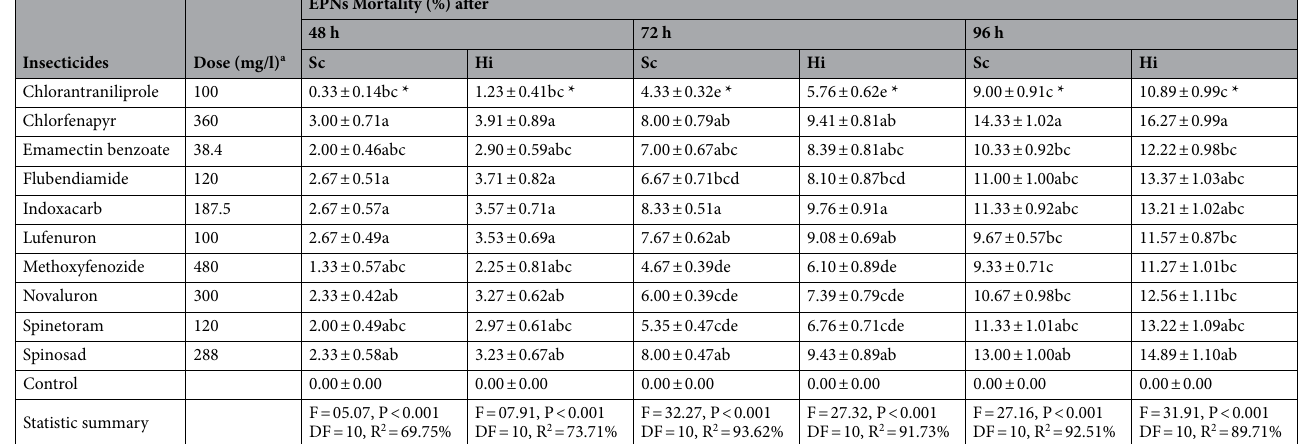
Table 3. Toxicity of selected insecticides against entomopathogenic nematodes. Sc S. carpocapsae , Hi H. indica. * Means followed by the same letter within a column do not differ significantly at 5% probability. a Field recommended dose rates against S. litura and to each insecticide treatment 100 IJs of selected EPN species were added.